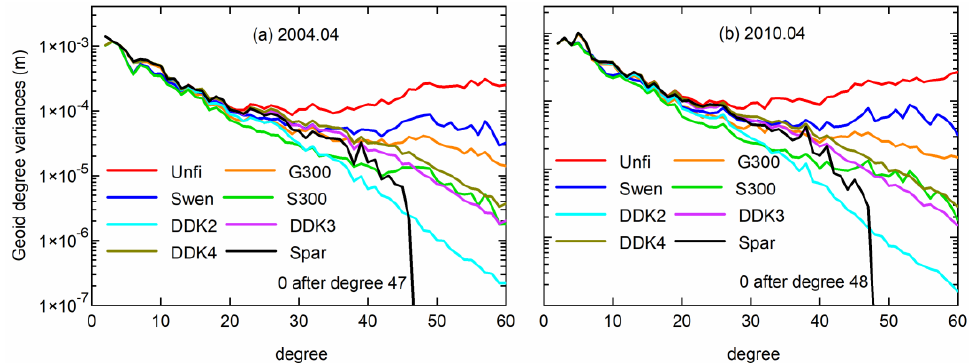
Figure 7. The geoid degree-variance of filtered monthly solutions for: ( a ) April 2004, ( b ) April 2010. The high-degree variances of sparse DDK filtered solutions are strictly equal to zero.